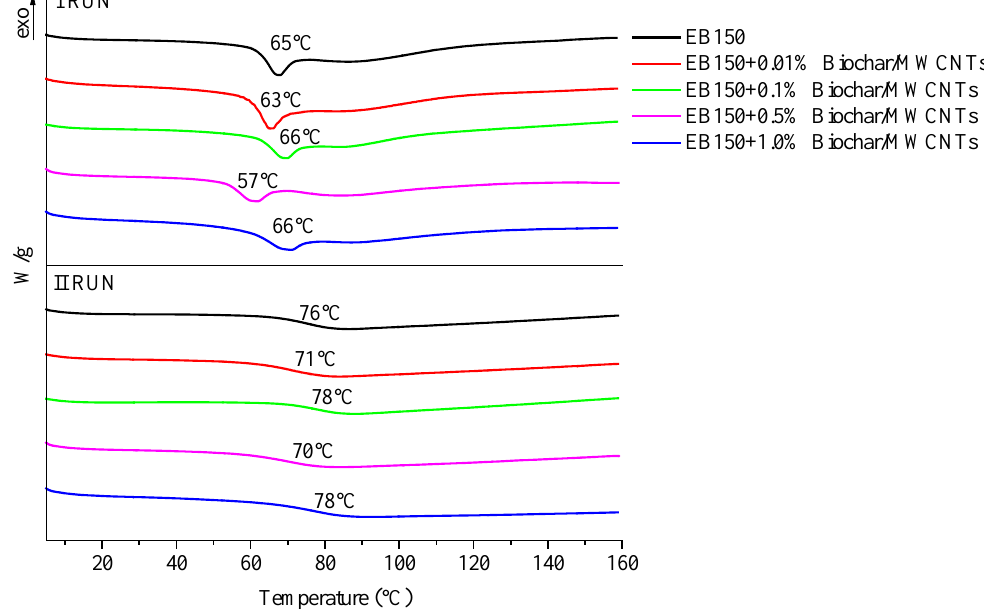
Figure 9. DSC traces (1st and 2nd heating up) for UV-LED cured EB150 and its composites with different MWCNTs loadings.